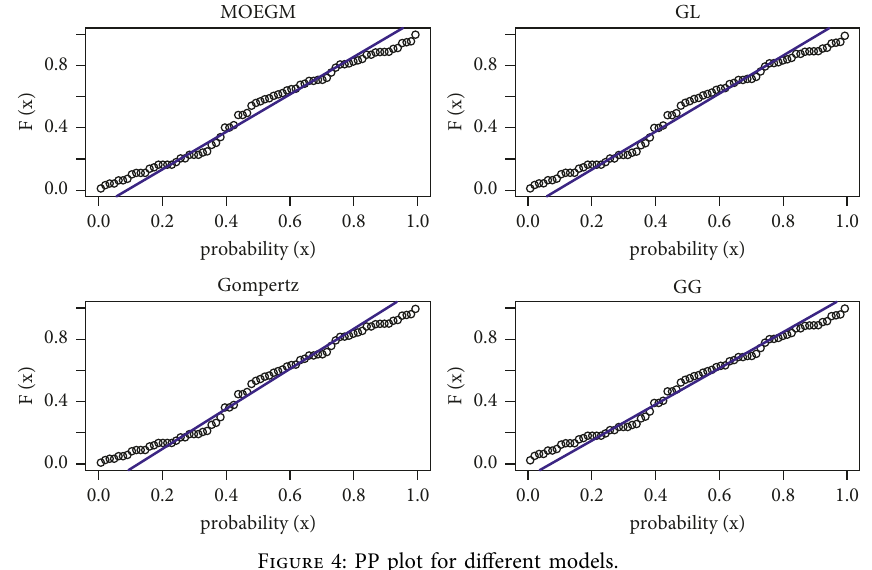
Figure 4: PP plot for different models.